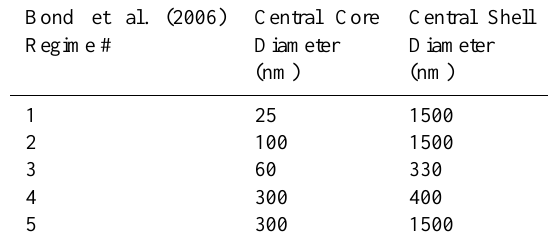
Table 2. Central core and shell diameters from the five E Abs regimes of Bond et al. (2006)